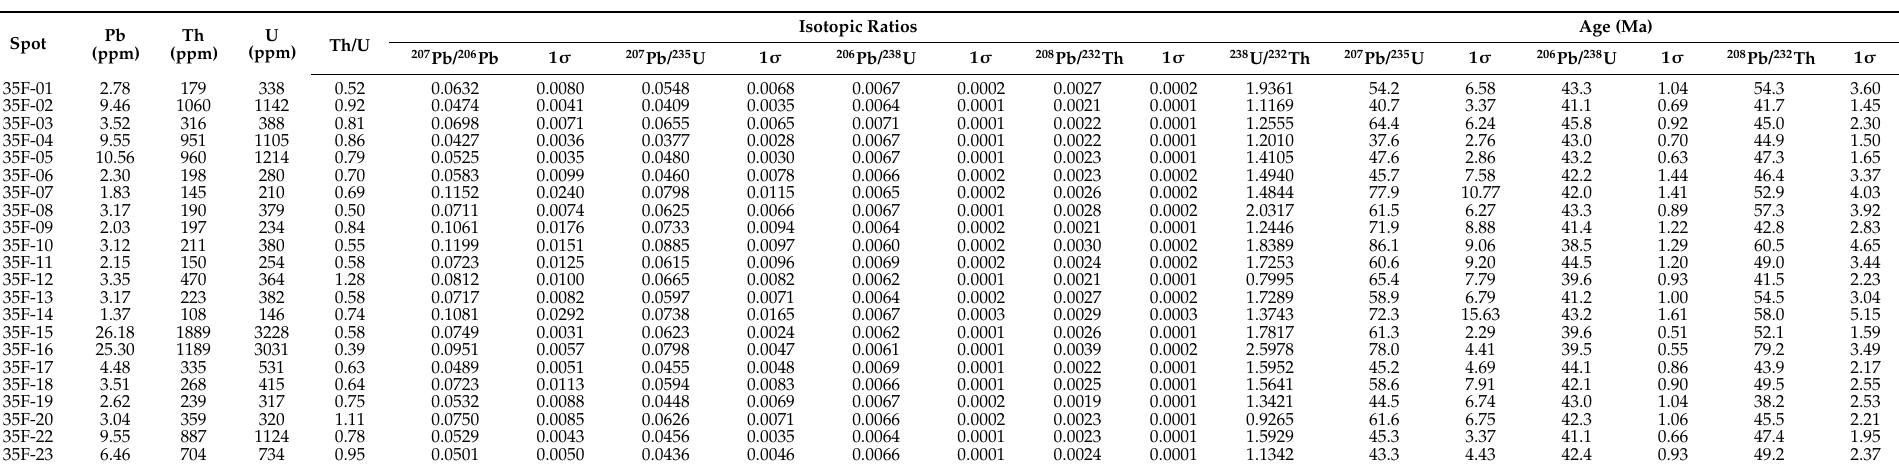
Table 3. LA-ICP-MS zircon U–Pb dating data of the dyke